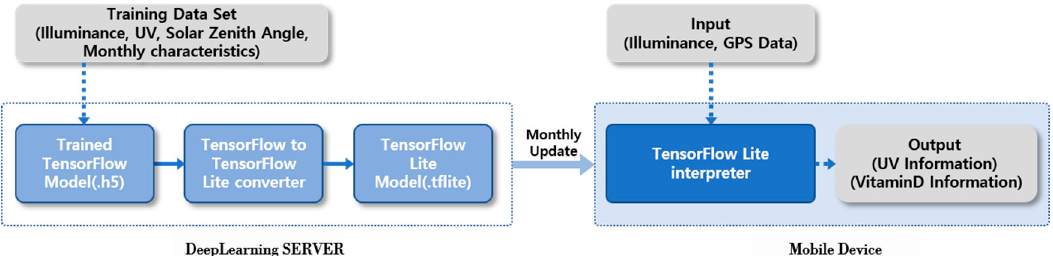
Figure 4. Construction and execution flow of the mobile deep learning model.